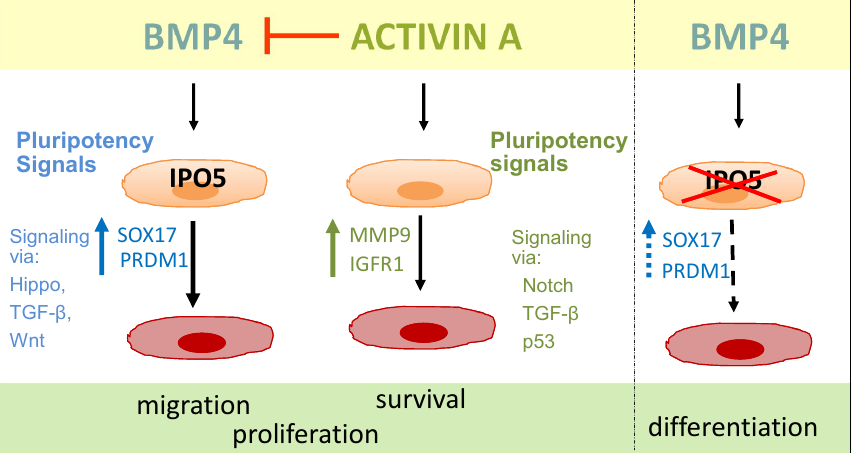
Figure 6. Summary: Both Activin A and BMP4 modulate a number of different signalling pathways that can alter migration, cell proliferation, survival, and differentiation in germ cells; ultimately determining the tumorigenicity of the cells. The elevation of activin A can dampen the BMP signalling response, presumably by competing for access to receptors and intracellular signalling